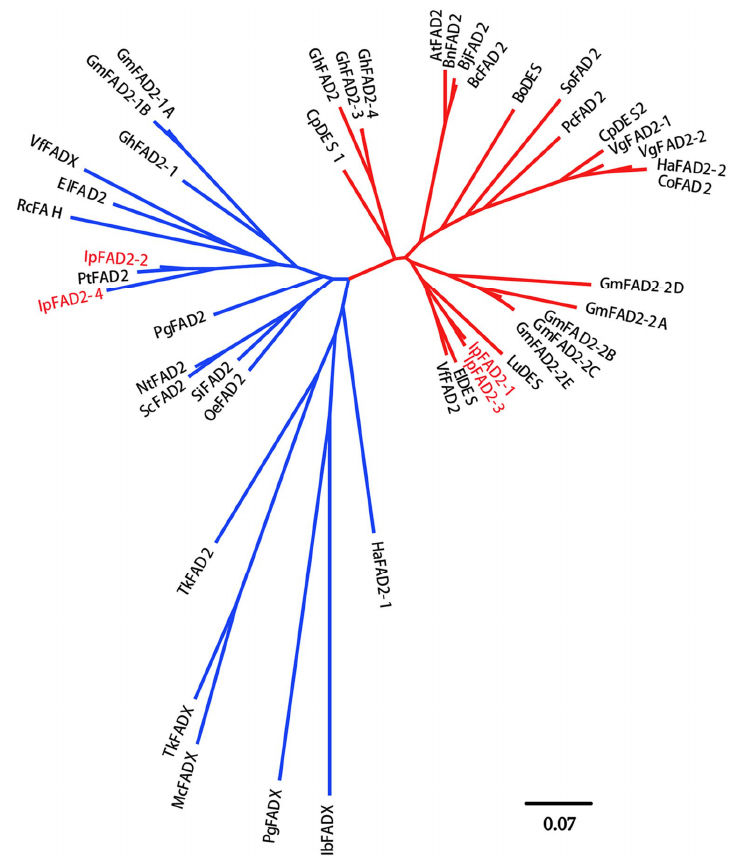
Figure 2. Cladogram of four IpFAD2s and other plant FAD2-related polypeptides. The house-keeping clade and the seed-type clade are labeled in red and blue accordingly. The four FAD2 homologs from Idesia polycarpa were designated IpFAD2-1, 2, 3, 4 and were labeled in red. The protein sequences used here were: GmFAD2-1A (Glyma.10G278000.1.p), GmFAD2-1B (Glyma.20G111000.1.p), GmFAD2-2A (Glyma.19G147300.1.p), GmFAD2-2B (Glyma.19G147400.1.p),